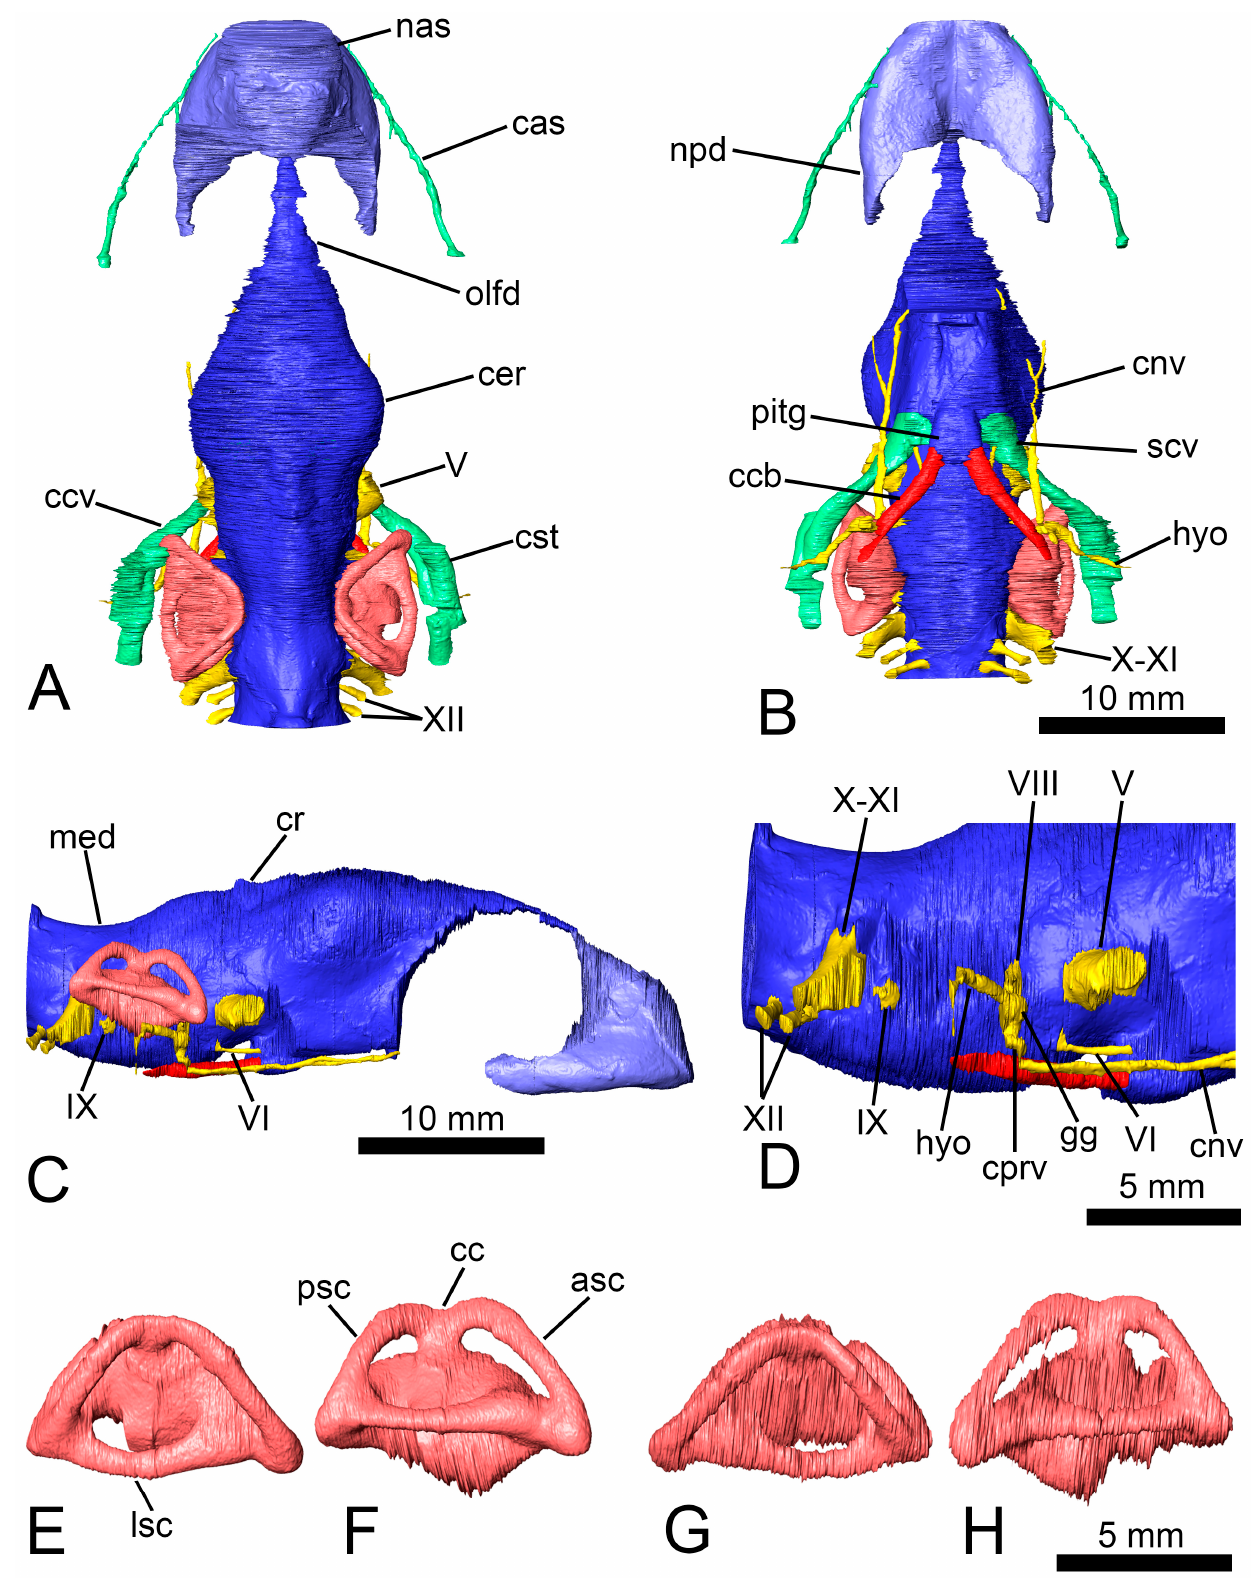
Figure 4. FR 4922, neuroanatomical three-dimensional virtual reconstructions of the skull of the holotype of Euraxemys essweini (Euraxemydidae) from the Albian of Araripe Basin in Brazil in dorsal ( A ), ventral ( B ), and lateral ( C , D ) views. Right ( E , F ) and left ( G , H ) inner ears in dorsal ( E , G ) and lateral ( F – H ) views.